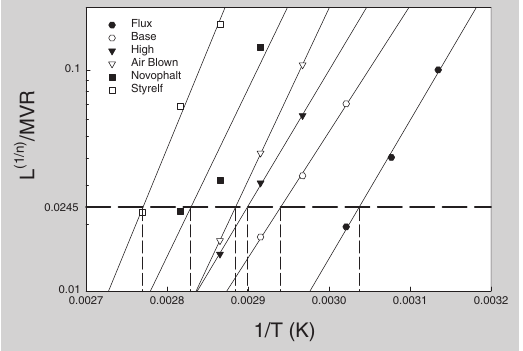
were also included, namely, PG76-22 (Novophalt)